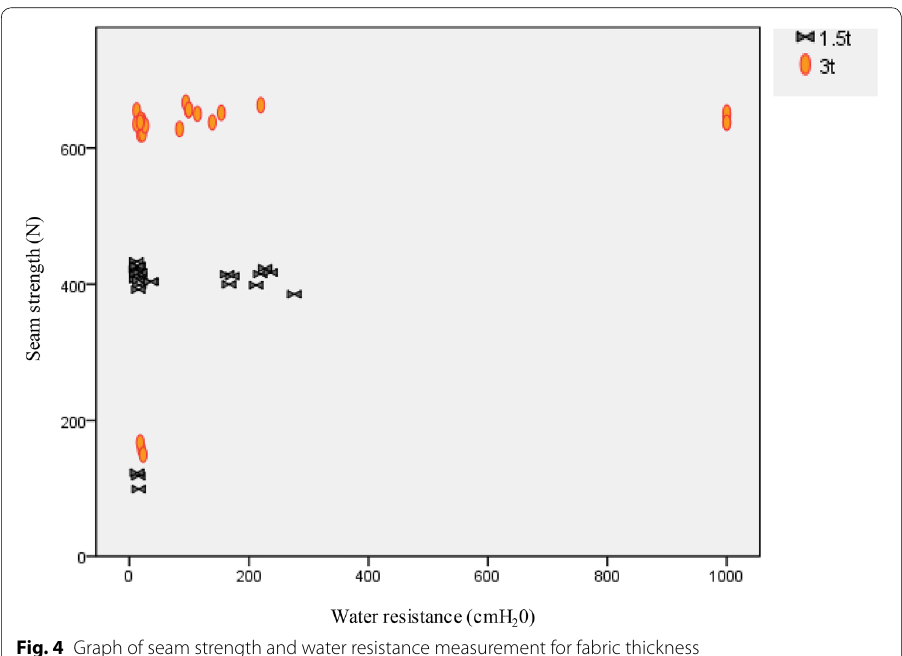
Fig. 4 Graph of seam strength and water resistance measurement for fabric thickness